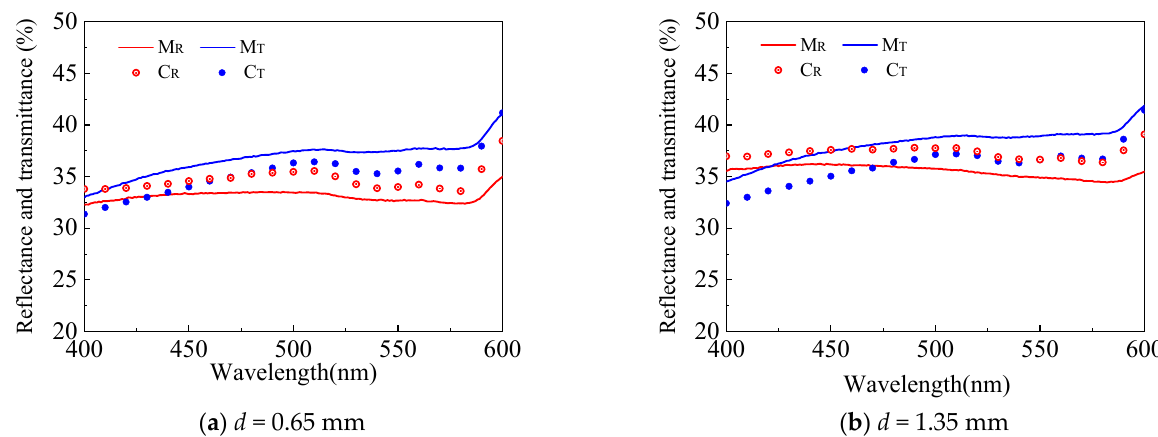
Figure 15. Comparison between the measured and calculated spectroscopic data in the discrete vessel skin phantom with different depths.